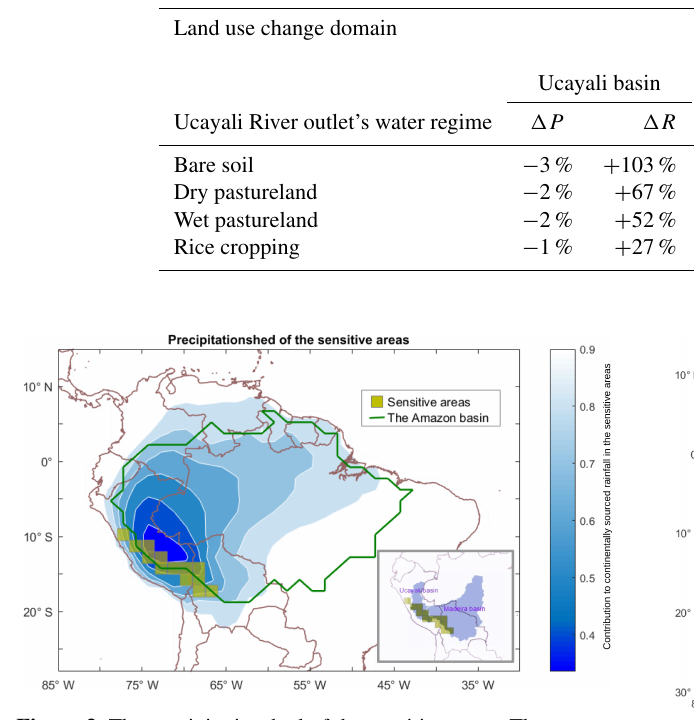
Figure 4. Different land use scenario domains for exploring rain- fall and runoff susceptibility of the target sink (Ucayali River out- let). These domains include the Ucayali River basin (the watershed of the target sink), the MIP of the target sink, and the MIP of the Ucayali River basin (the MIP of the watershed) but excluding the basin component cells, in order to understand land use change in- fluences outside of the watershed boundary. In addition, land use scenarios are also applied in the domains of the Amazon basin and the Amazon basin without the Ucayali River basin for upper bound